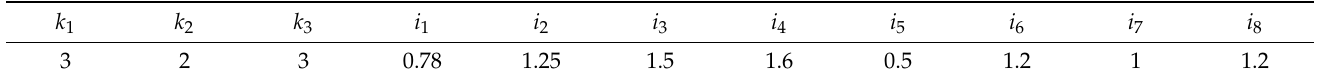
Table 2. Transmission parameters of three-planetary-row HMCVT